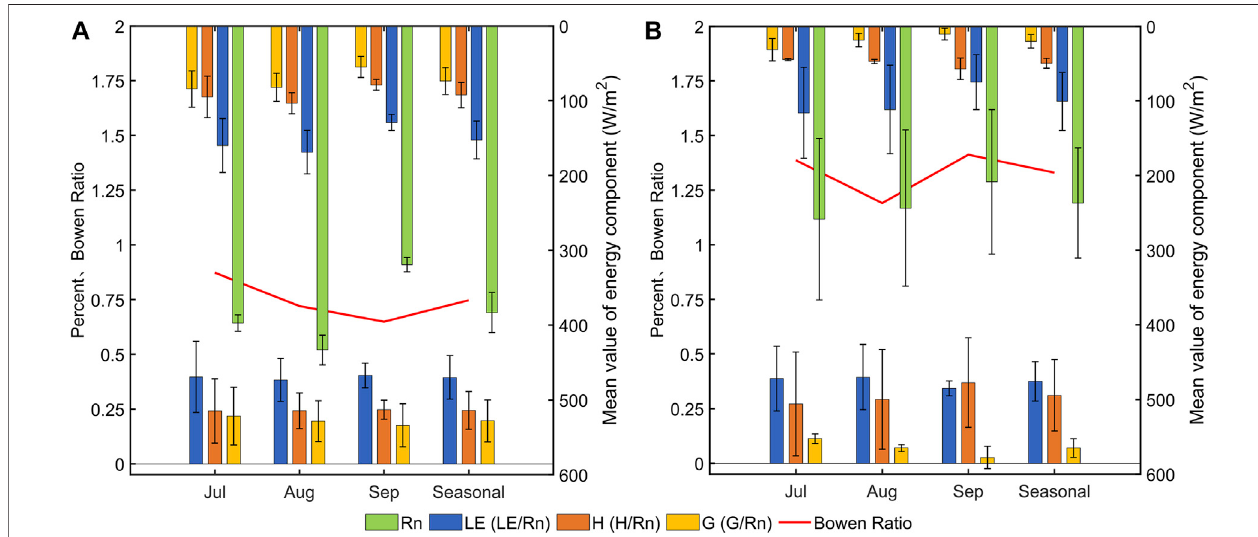
FIGURE6| Monthlyandseasonalaveragesoftheenergycomponents,ratiostonetradiation,andBowenratiosinthe (A) westernand (B) easternregions. R n isthe net radiation, LE is the latent heat fl ux, H is the sensible heat fl ux, and G is the soil heat fl ux.